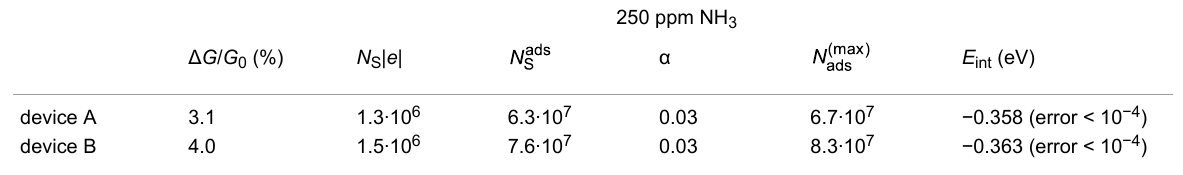
Table 2: Summary of the relevant quantities descending from the interaction between graphene (devices A and B) and 250 ppm of NH 3 during 10 min of exposure, calculated based on the responses reported in Figure